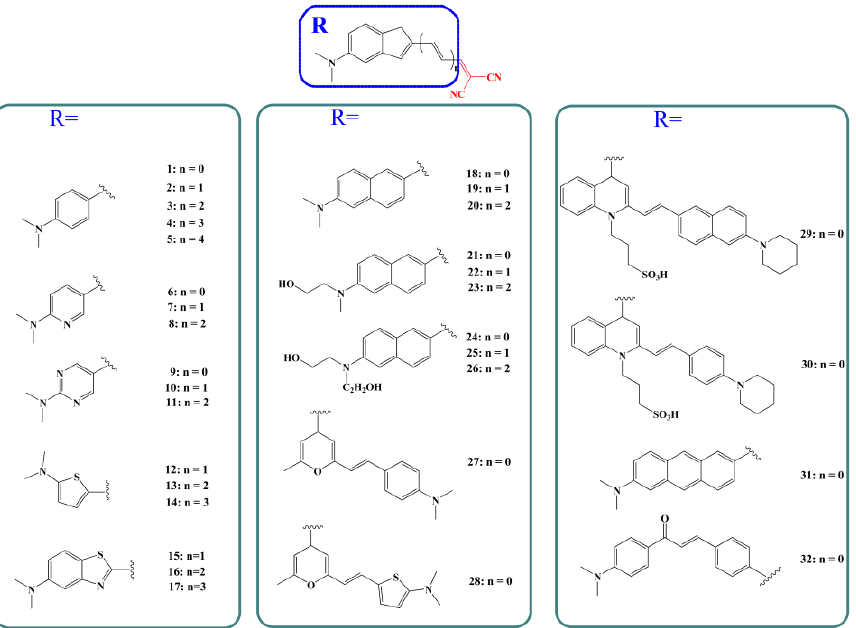
Figure 1. Various binding sites of the probes in β -amyloid (taken probe 1 as the example).